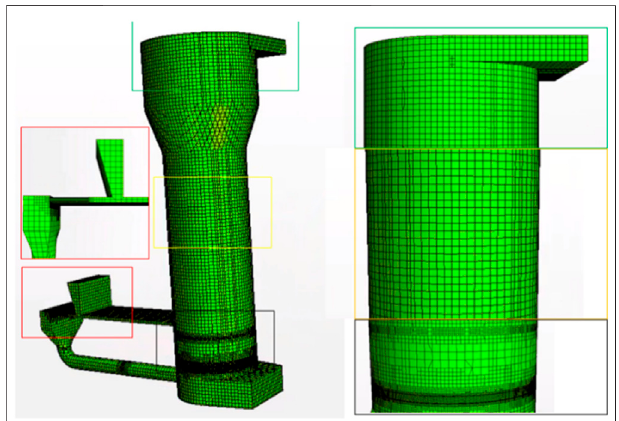
FIGURE 3 | Simulation model of the CTD drying